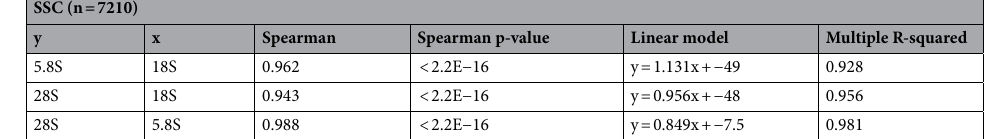
Table 8. Correlations between the three rRNA genes encoded in the 45S repeat unit in the Simons Simplex Collection. The Spearman correlation coefficient and linear models that describe the relationships between the 18S, 5.8S, and 28S copy numbers are